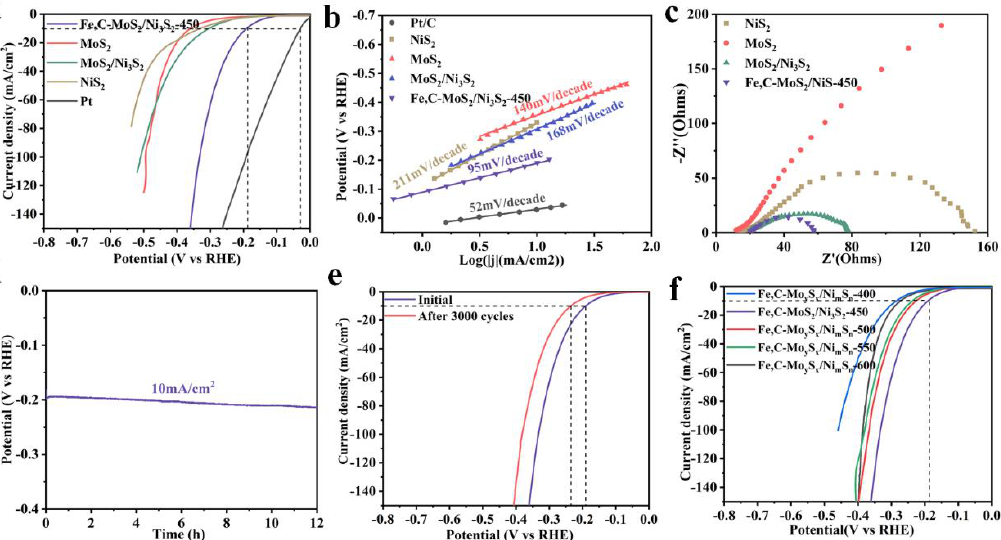
Figure 4. ( a ) Polarization curves and ( b ) the corresponding Tafel plots; ( c ) electrochemical impedance spectroscopy (EIS) analysis of the obtained sample for hydrogen evolution reaction (HER). ( d ) Chronopotentiometric curve of HER for the Fe,C-MoS 2 /Ni 3 S 2 -450. ( e ) Linear sweep voltammetry LSV polarization curves of the Fe,C-MoS 2 /Ni 3 S 2 -450 before and after 2000 cycles. ( f ) LSV polarization curves of samples by different annealing temperatures.